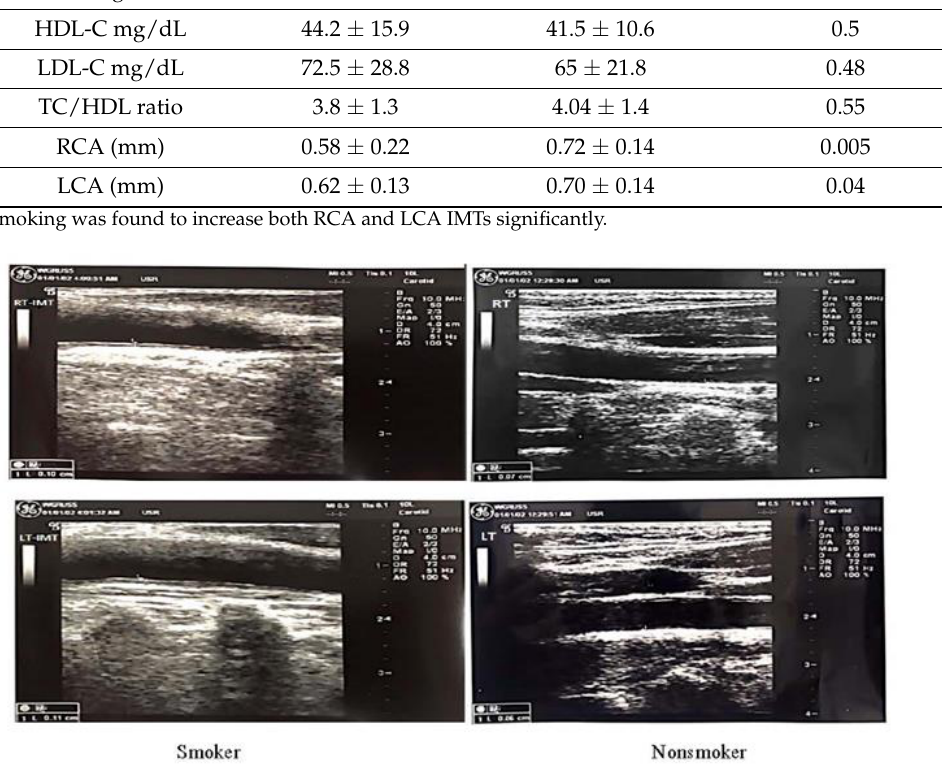
Table 3. The effect of the duration and frequency of smoking on the mean values of the studied